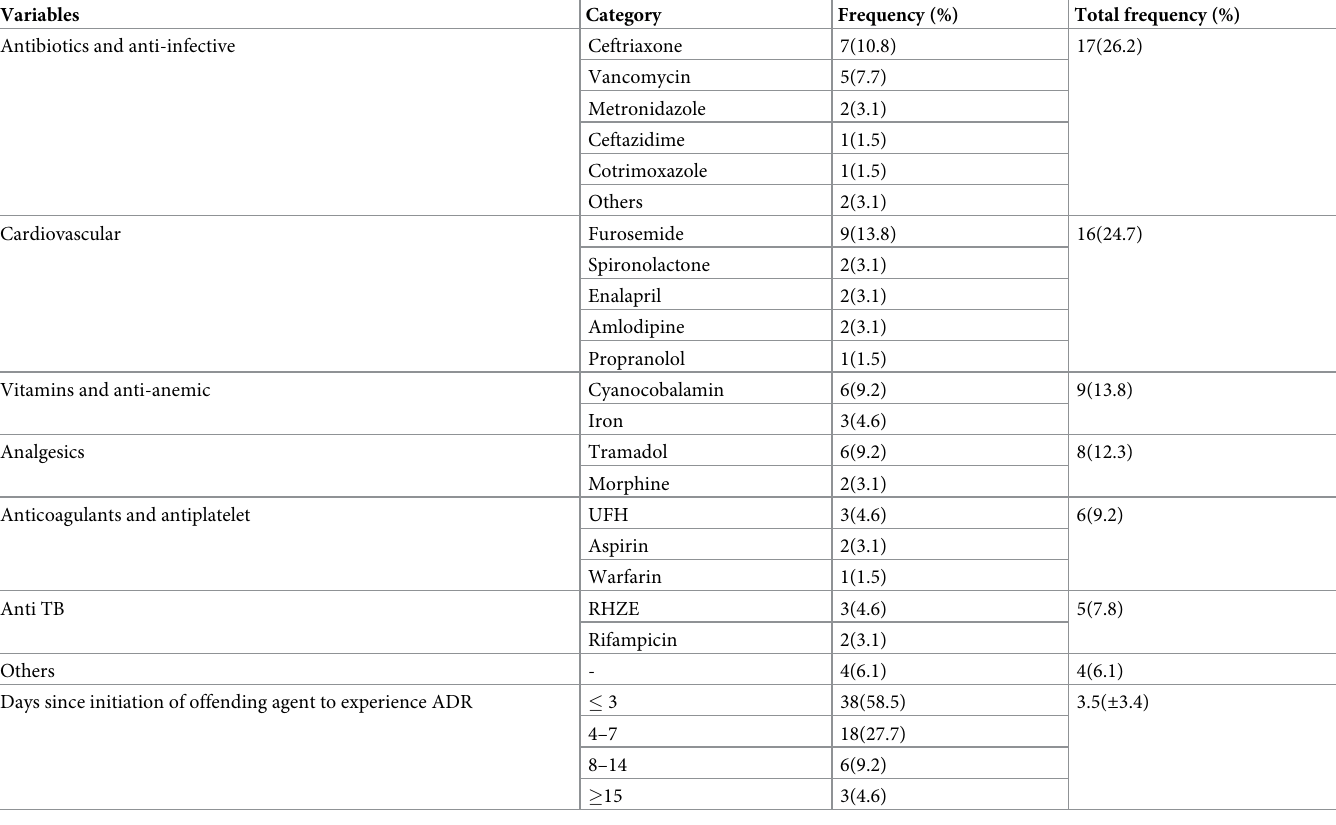
Table 7. Potential offending agents for the experienced ADRs (N = 65).